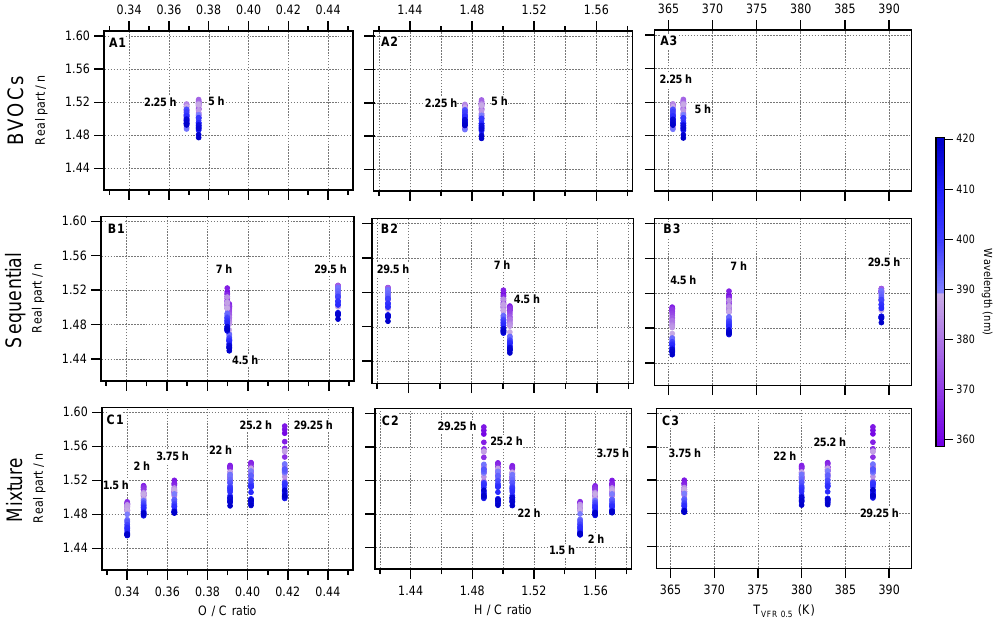
Figure 4. The change in time (given in hours, shown next to the retrieved values) for the retrieved real part of the RI as a function of O/C ratio (panels A1 , B1 , and C1 ), H/C ratio (panels A2 , B2 , and C2 ), and T VFR0 . 5 (the temperature at which the volume fraction remaining was reduced by half; panels A3 , B3 , and C3 ). The top panels – (A1) , (A2) and (A3) – show the results for the SOA produced from a 1:1 mixture of α -pinene and limonene. The middle panels – (B1) , (B2) , and (B3) – show the results for the SOA produced from the mixture of α -pinene, limonene, and p -xylene-d 10 . The lower panels – (C1) , (C2) , and (C3) – show the results for the SOA produced from the sequential addition of the mixture of α -pinene and limonene followed by p -xylene-d 10 . The color scale indicates the measured wavelength. For clarity, the error bars for the O/C (31%), H/C (10%), and T VFR0 . 5 are not shown. The average error for the T VFR0 . 5 is 2.3K.